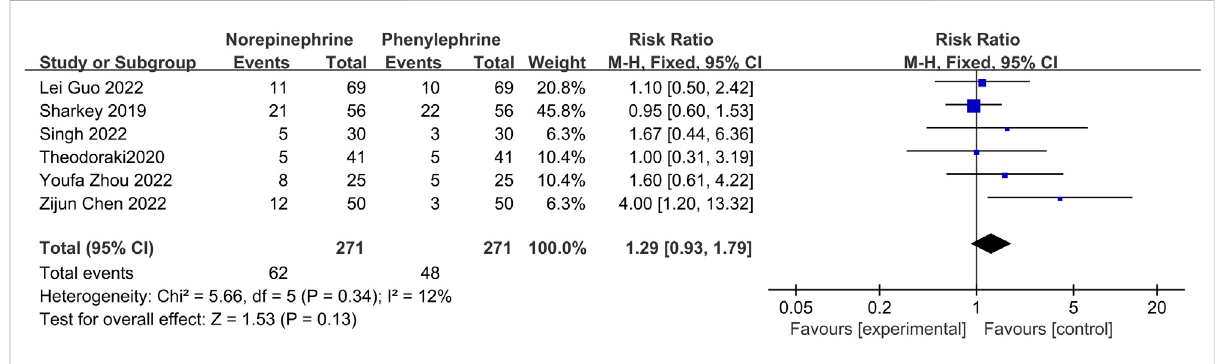
FIGURE 4 A Forest plot of the incidence of hypotension following treatment with either norepinephrine or phenylephrine.